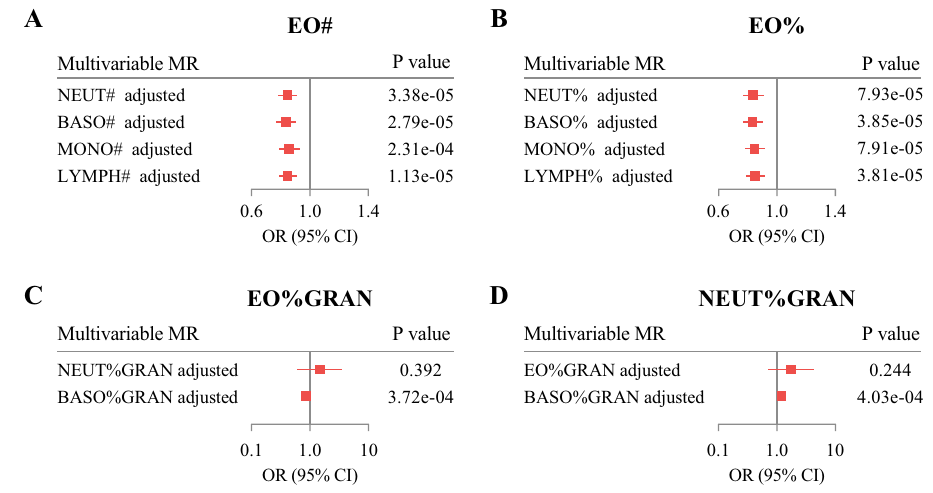
Figure 3. Multivariable MR analysis for four HBC traits adjusting for variables within the same category. ( A ) Effect of EO# on EPs, adjusting for NEUT#, BASO#, MONO#, and LYMPH#; ( B ) effect of EO% on EPs, adjusting for NEUT%, BASO%, MONO%, and LYMPH%; ( C ) effect of EO%GRAN on EPs, adjusting for NEUT%GRAN and BASO%GRAN; ( D ) effect of NEUT%GRAN on EPs, adjusting for EO%GRAN and BASO%GRAN. Results are expressed as ORs and 95% CIs per 1 SD of each HBC trait. HBC human blood cell, EPs endometrial polyps.